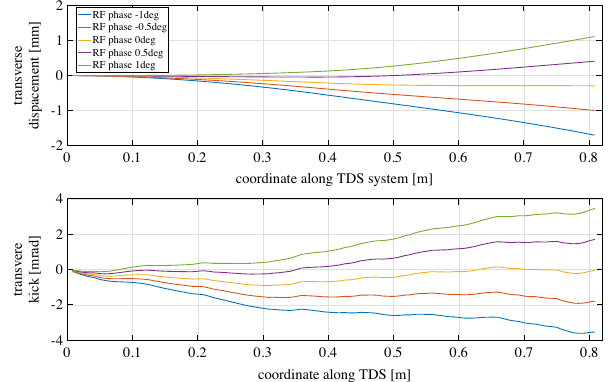
FIG. 16. Effects of the phase advance errors on the transverse displacement of the centroid (top) and on the transverse kick (bottom) along the TDS and for different rf phases.